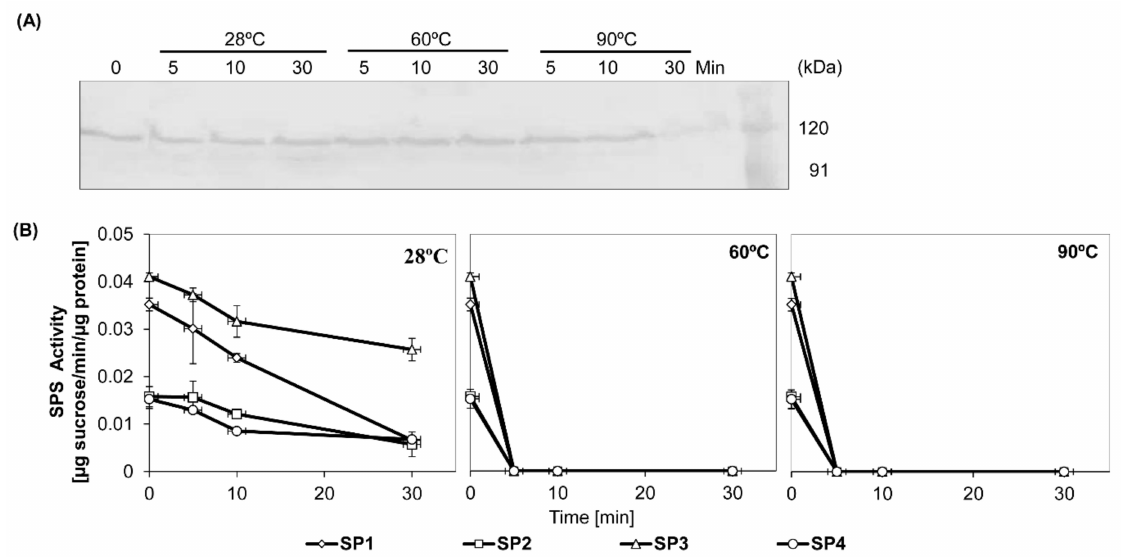
Figure 1. Heat stability of sucrose–phosphate synthase (SPS) protein extracted from leaves of transgenic sugarcane. The crude extract protein of transgenic sugarcane was subjected to heat treatment at indicated temperature for periods of 0, 5, 10, and 30 min. As a control, the extract protein was not subjected to any heat treatment (0 min). The level of SPS protein was monitored by Western blotting and the SPS was comparable in size with the molecular mass marker at 120 kDa ( A ). The activity level of SPS was measured using spectrophotometer at 520 nm before and after a heat treatment ( B